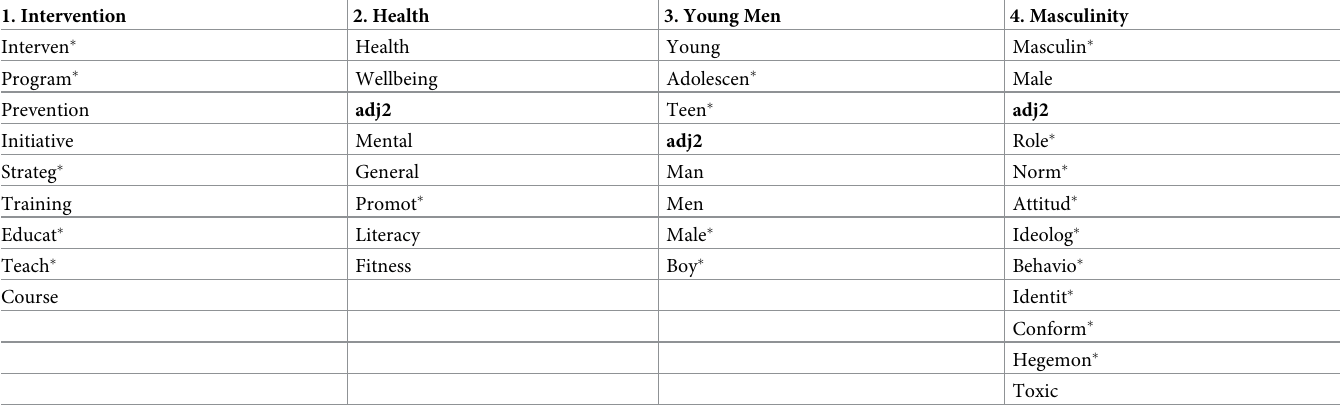
Table 1. Search terms by grouping